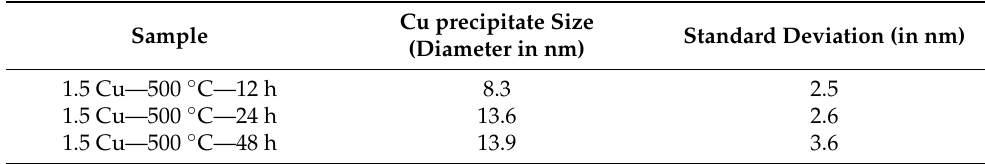
Table 3. The size evolution of Cu precipitates inside the martensitic needles after tempering at 500 ◦ C for 12 h, 24 h and 48 h.